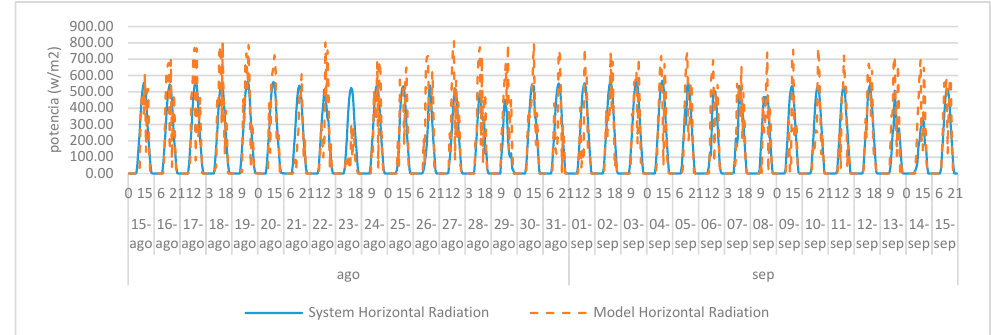
Figure 12. Horizontal radiation for the system and the model.